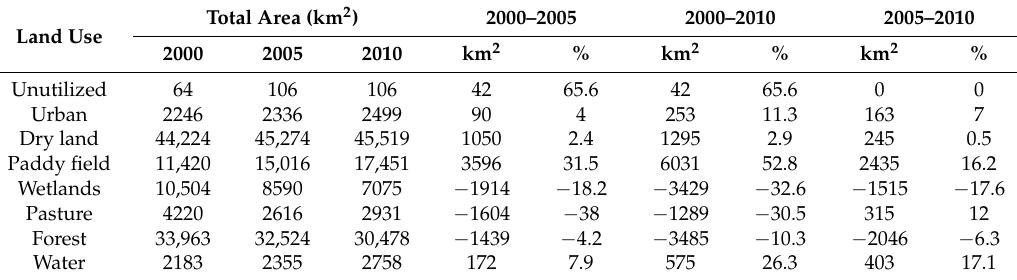
Table 2. Estimated areas of each land use and land use changes from 2000 to 2010.